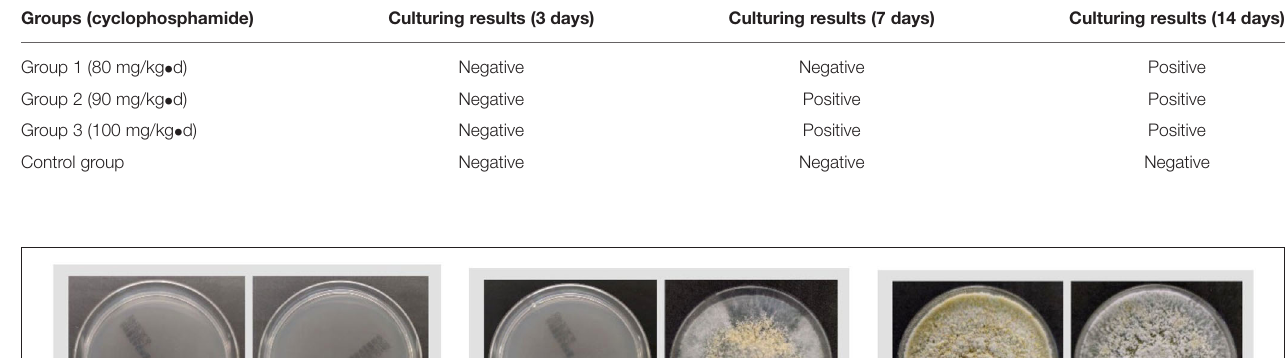
TABLE 1 | Results of tissue fungal cultures of mice inoculated with Trichoderma longibrachiatum (PKUT180420015) in each group. Groups (cyclophosphamide)